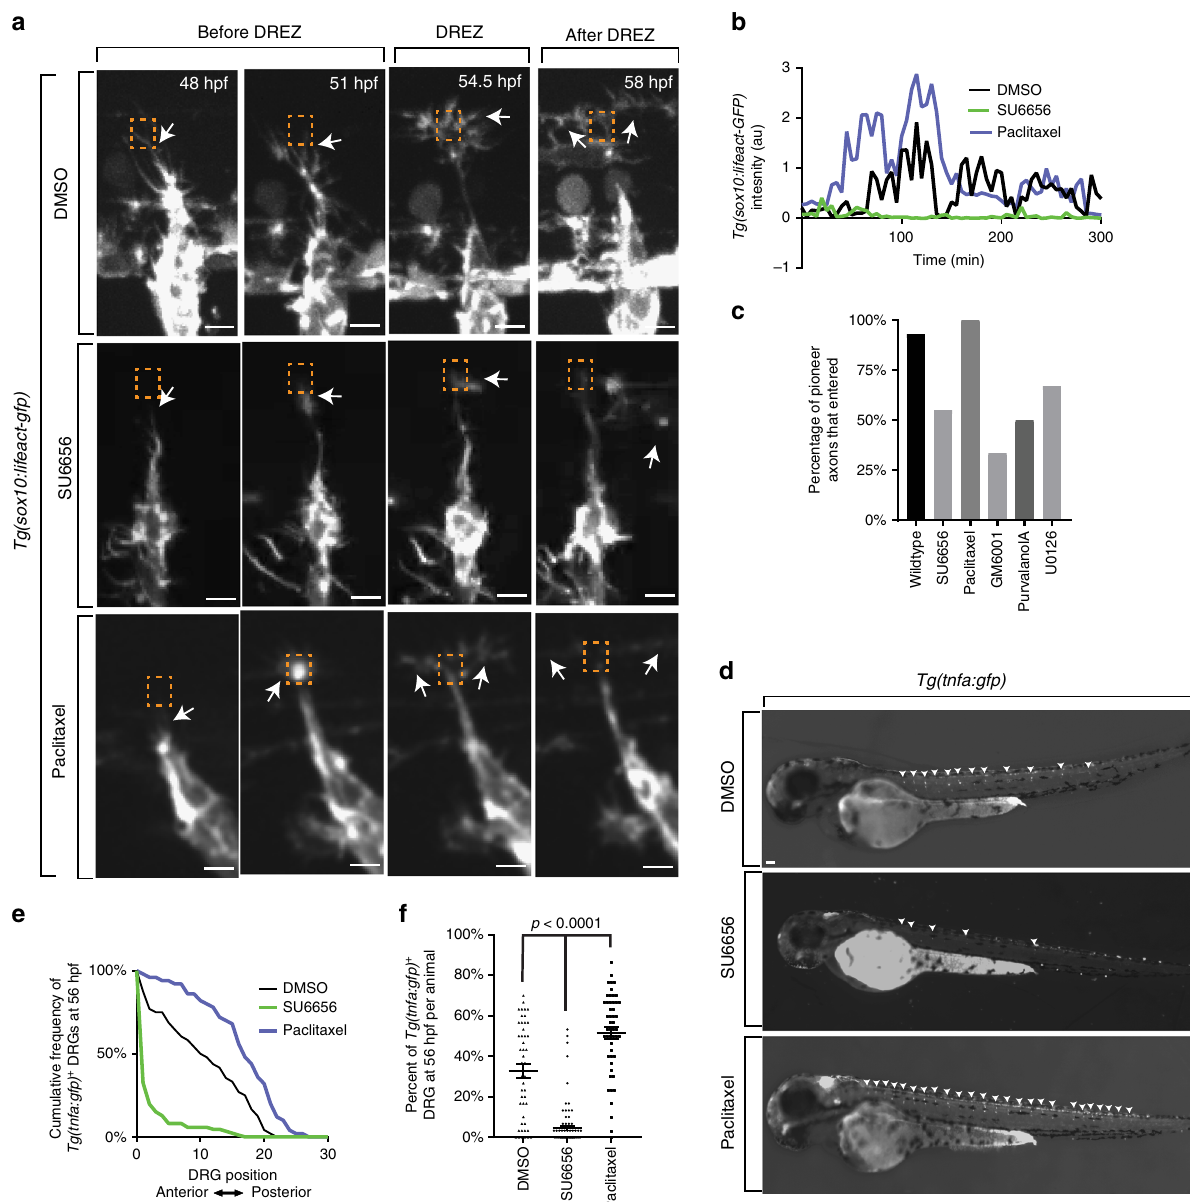
Fig. 5 Actin-rich invasion components are necessary and suf fi cient for axon entry. a Confocal z -projection frames from a 24-h time-lapse starting at 48 h post fertilization (hpf) of Lifeact-GFP animals showing navigation of the pioneer axon into the spinal cord in animals treated with dimethyl sulfoxide (DMSO), SU6656, and paclitaxel. White arrows denote the tip of the growth cone. Orange dotted box denotes dorsal root entry zone (DREZ). Axon approaches DREZ at 300 min. b Representative intensity pro fi les of Lifeact-GFP expression at the growth cone in animals treated with DMSO (black), SU6656 (green), and paclitaxel (blue). SU6656-treated axons fail to form actin concentrates, while paclitaxel-treated axons form early and robust concentrates. Gray box denotes the formation of actin-rich invasion components in the DMSO- and paclitaxel-treated animals. c Quanti fi cation of axons that entered the spinal cord in animals treated with DMSO ( n = 14 dorsal root ganglia (DRG)), SU6656 ( n = 20 DRG), paclitaxel ( n = 13 DRG), GM6001 ( n = 18), purvalanol A ( n = 18 DRG), and U0126 ( n = 20 DRG). Inhibitors of cell invasion prevent axon entry. d Lateral images taken at 56 hpf of Tg(tnfa: gfp) animals treated with DMSO, SU6656, or/and paclitaxel. Arrowheads denote Tg(tnfa:gfp) + DRG. e Cumulative frequency of animals treated with SU6656, paclitaxel, and DMSO that express Tg(tnfa:gfp) at each DRG at 56 hpf; n = 86 SU6656-treated fi sh, n = 50 paclitaxel-treated fi sh, n = 48 DMSO- treated fi sh. f Bar graph of the percentage of DRG that were Tg(tnfa:gfp) + at 56 hpf in animals treated with SU6656, paclitaxel, and DMSO; n = 86 SU6656-treated fi sh, n = 50 paclitaxel-treated fi sh, n = 48 DMSO-treated fi sh. SEM is shown. Scale bars denote 10 µ m in ( a ) and 0.1 mm in ( d ). One-way analysis of variance (ANOVA) ( f at 48 hpf, and then scored navigation and invadopodia formation measuring a difference in the Tg(gfap:nsfb-mcherry) intensity in in pioneer axons from 48 to 72 hpf (Fig. 7a, Supplementary lesioned and non-lesioned DREZ (Supplementary Figure 5e). In Movie 8). In SU6656-treated animals with lesioned DREZ the SU6656-treated non-lesioned DREZ, pioneer axons rarely entered Lifeact-GFP peak was shorter, consistent with SU6656 treatment the spinal cord. However, SU6656-treated animals with lesioned (Supplementary Figure 5a-d). We con fi rmed the lesion by DREZ fully recovered spinal cord entry (Fig. 7b). These data are